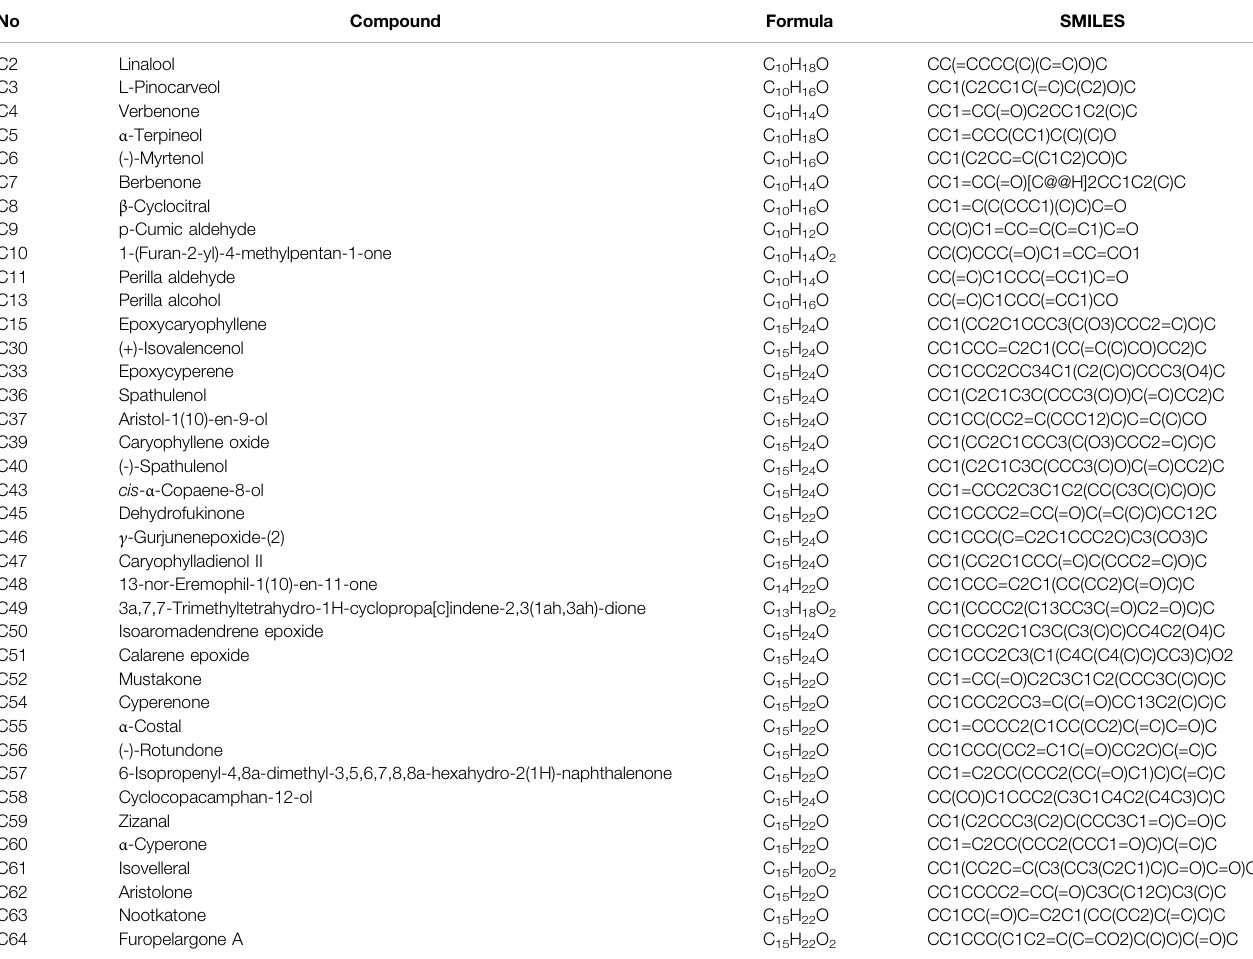
TABLE 2 | Compounds of XS volatile oil after ADME